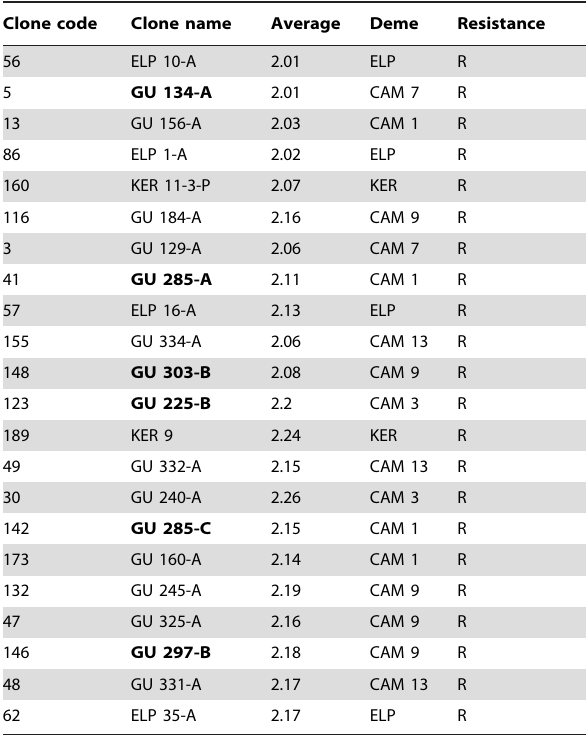
Table 2. List of resistant clones (ordered according to their effect in the ordinal probit model), their average score after 10 series of tests, and their